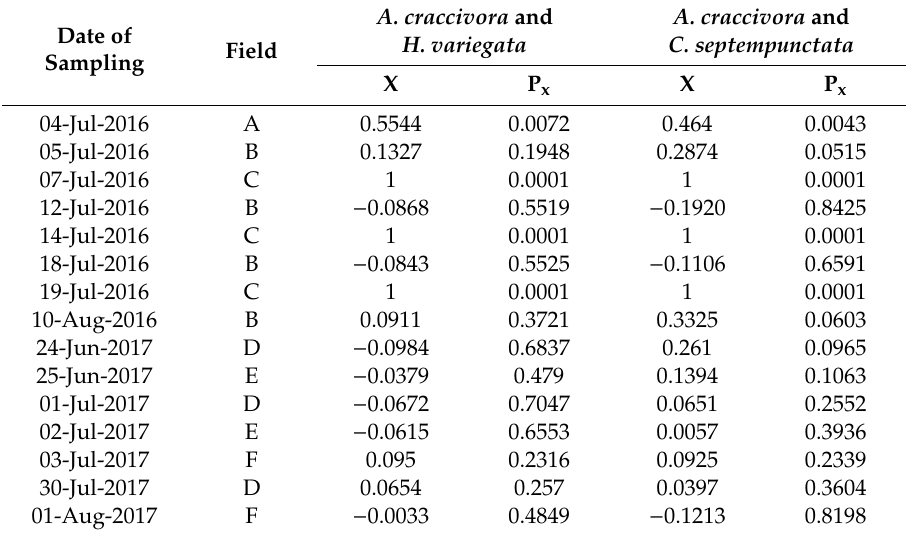
Table 5. Spatial association between Aphis craccivora and Coccinellids ( Coccinella septempunctata and Hippodamia variegata